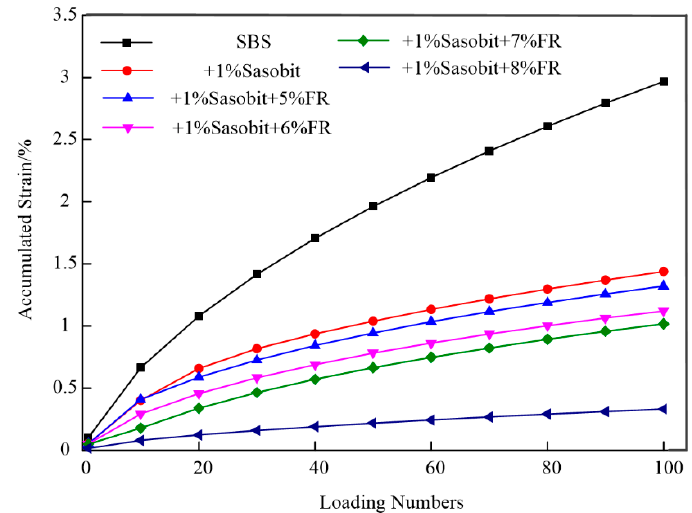
Figure 9. The relationship between loading numbers and cumulative strain at 30 °C.